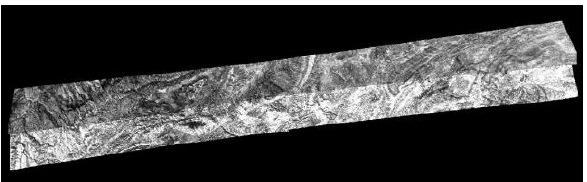
Figure 9. Image mosaic without radiometric balancing.